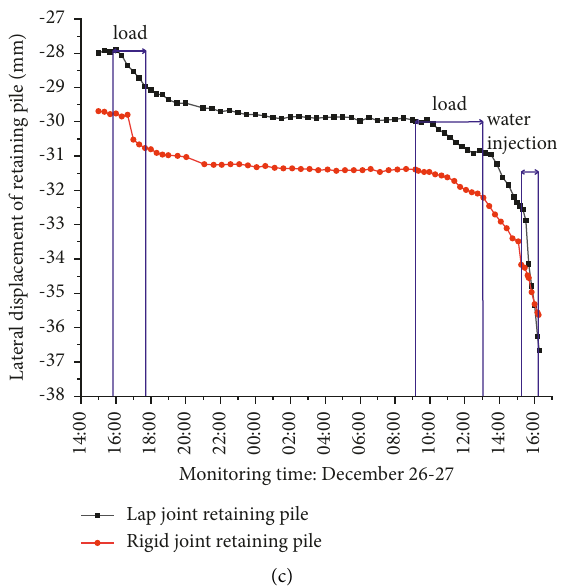
Figure 11: Comparison diagram of horizontal displacement of retaining pile at each measuring point. (a) Measuring point at (b) measuring point at 2 m depth, and (c) measuring point at − displacement of the retaining pile to the foundation pit; “+” indicates the horizontal displacement of the retaining pile towards the soil layer outside the foundation